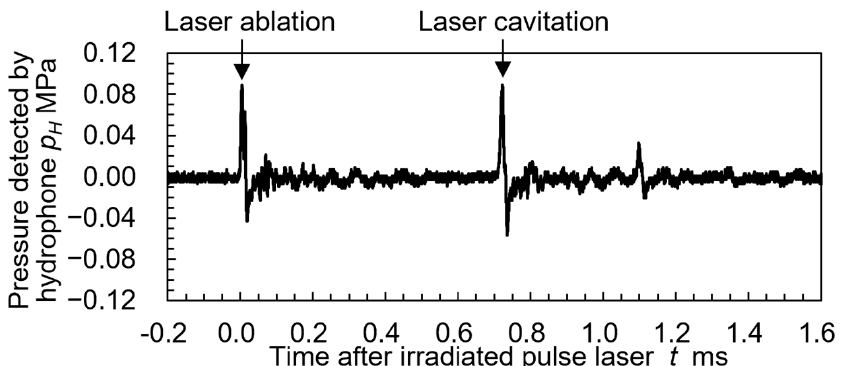
Figure 6. Signal from hydrophone during mechanical surface treatment using pulsed laser.